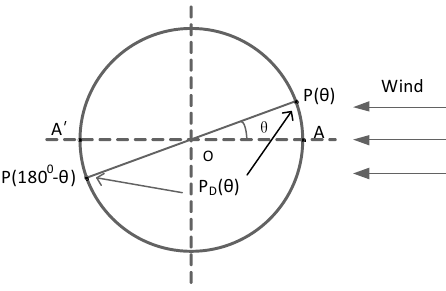
Figure 2. The pressure and pressure difference of a cylinder.